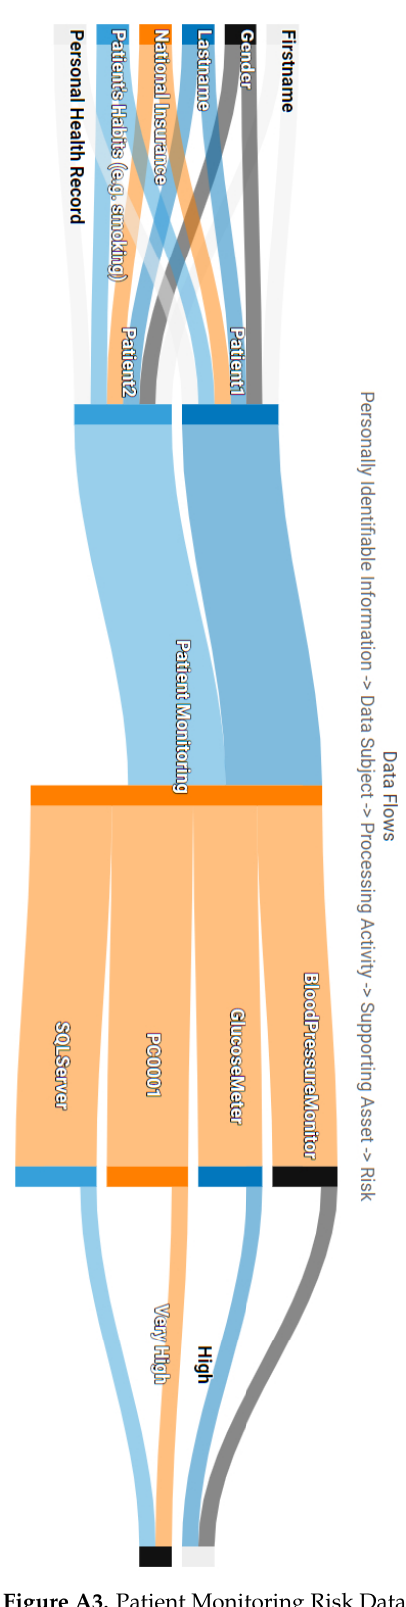
Figure A3. Patient Monitoring Risk Data